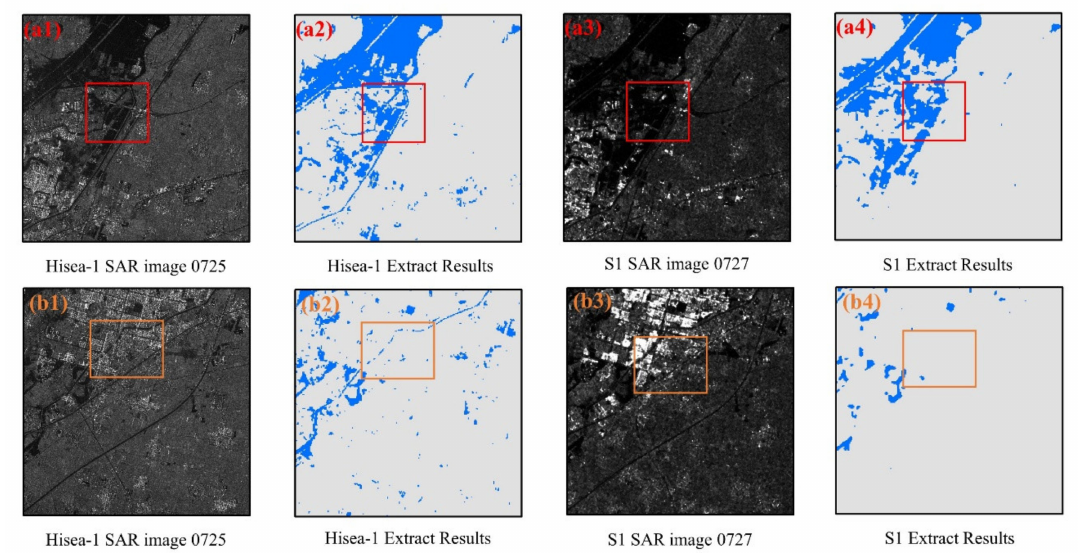
Figure 9. Comparison of the Hisea-1 image-extracted water area on 25 July 2021 and the S1 SAR image-extracted results on 27 July 2021. The figure was plotted by Arcmap10.2 software. ( a1 , b1 ) are the partial areas of Hisea-1 SAR image on 25 July 2021, ( a2 , b2 ) are the results of water area extraction based on Hisea-1 image. ( a3 , b3 ) are the corresponding areas of ( a1 , b1 ) of the Sentinel-1 SAR image on 27 July 2021, ( a4 , b4 ) are the results of water body extraction based on the original Sentinel-1